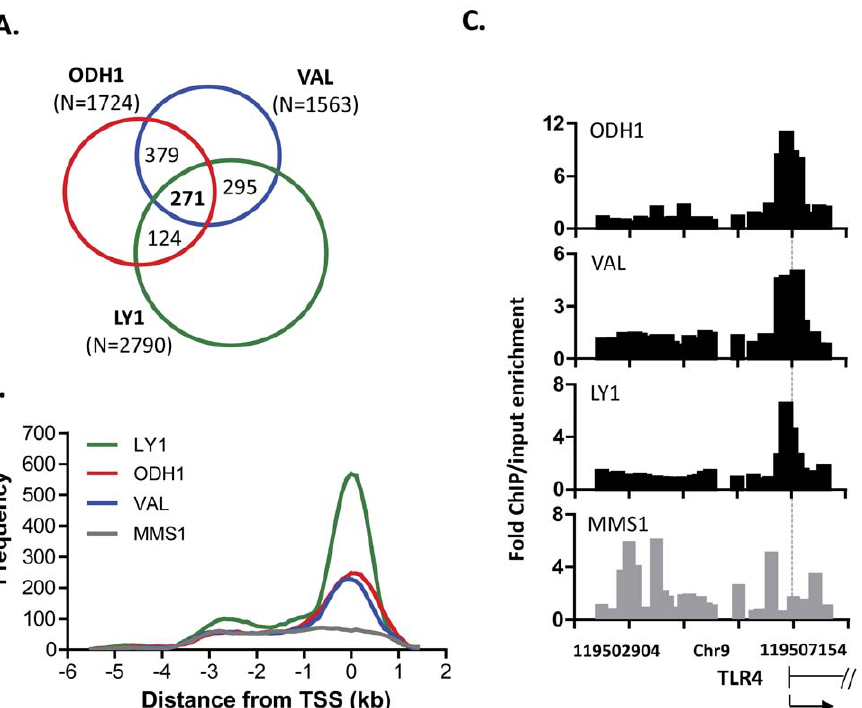
Figure 1. Identification of IRF8 targets in human cell lines of GC B cell origin. Labeled IRF8 ChIP samples and input samples from the three human cell lines of GC B cell origin were applied to Nimblegen HG18 385 k arrays and peak signals were analyzed by sliding window algorithm with threshold of FDR , 0.01. (A) Venn diagram of IRF8 targets in three cell lines. Numbers in parentheses indicate the numbers of targets identified in each line. Internal numbers indicate targets common to two or all three lines. (B) Distribution of IRF8-bound sites relative to the transcription start site (TSS) of target genes. (C) Representative IRF8 binding from ChIP-chip in four cell lines. Binding of IRF8 to the TLR4 promoter is shown as an example. Fold change is calculated from relative fold enrichment of IRF8 ChIP signal to input signal. Dashed line shows